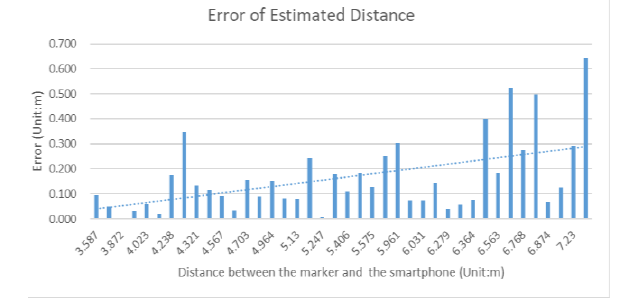
Figure 11. The error of estimated distance Sorting based on distances, the horizontal axis means the distances, and the vertical axis is the error. From Figure 11, we can find that the error trend of the distance estimated by the CCN model becomes larger when the distance is longer. Because when the distance increases, the marker might be more blur. The mean error of all 40 images is about 0.16 meters. Afterward,